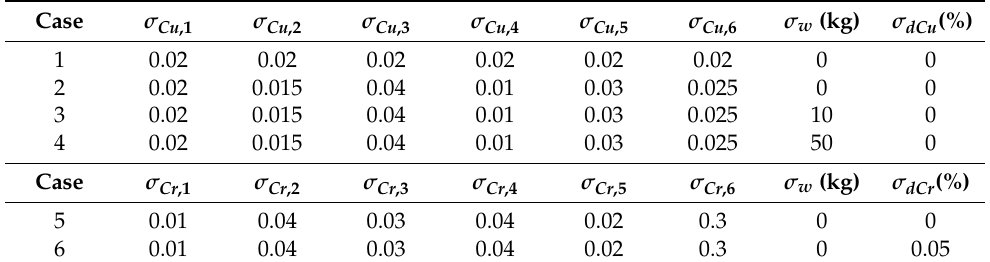
Table 3. Standard deviations for Cu and Cr in each scrap type, standard deviations for weighing and standard deviation for Cr distribution